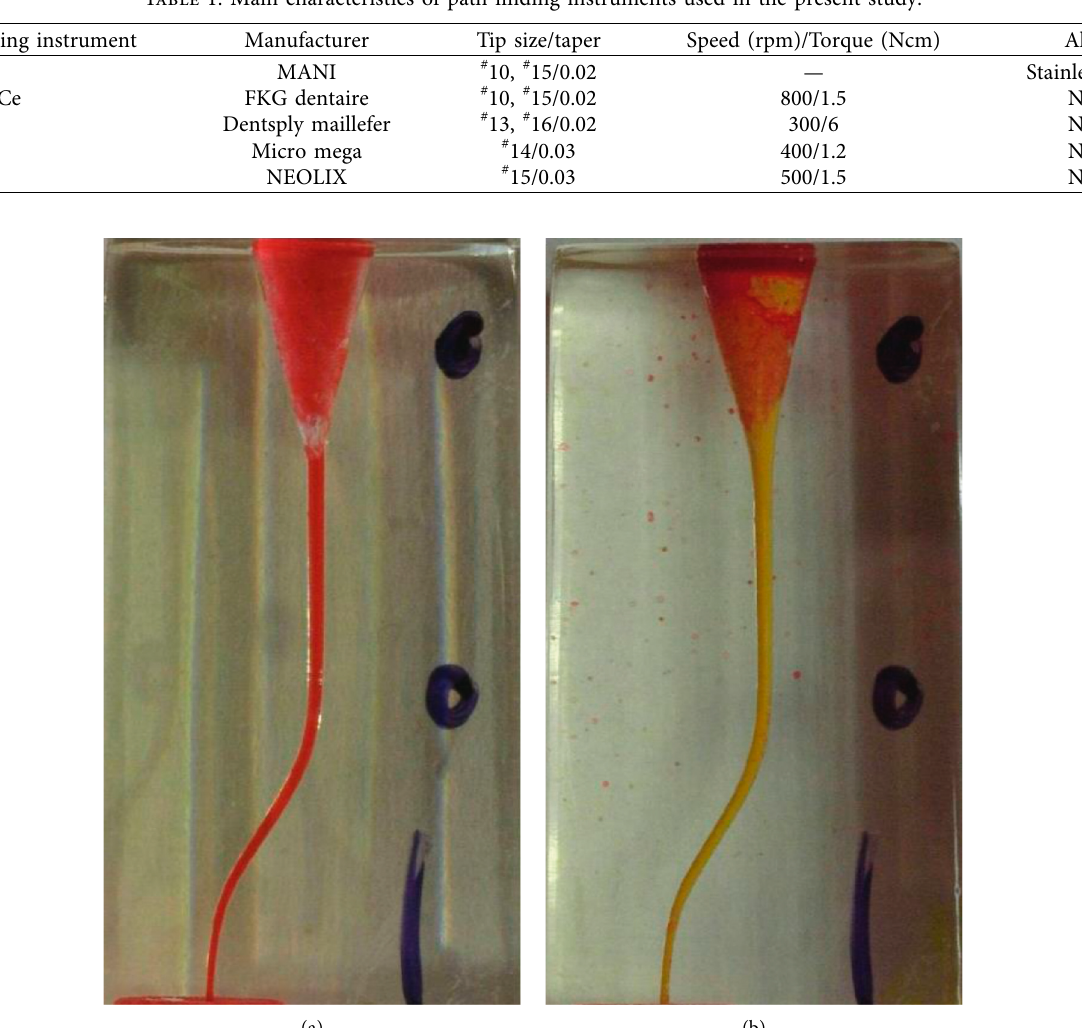
Figure 1: Before- (a) and after- (b) preparation photos of one of the blocks after painting with dyes; blocks were painted with red dye before instrumentation while they were painted with yellow dye after glide path creation.